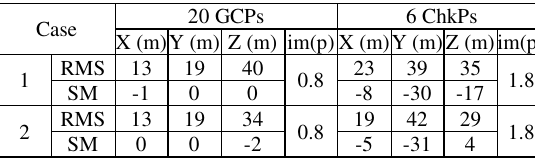
Table 2. GLAS Errors at Ground Control and Check